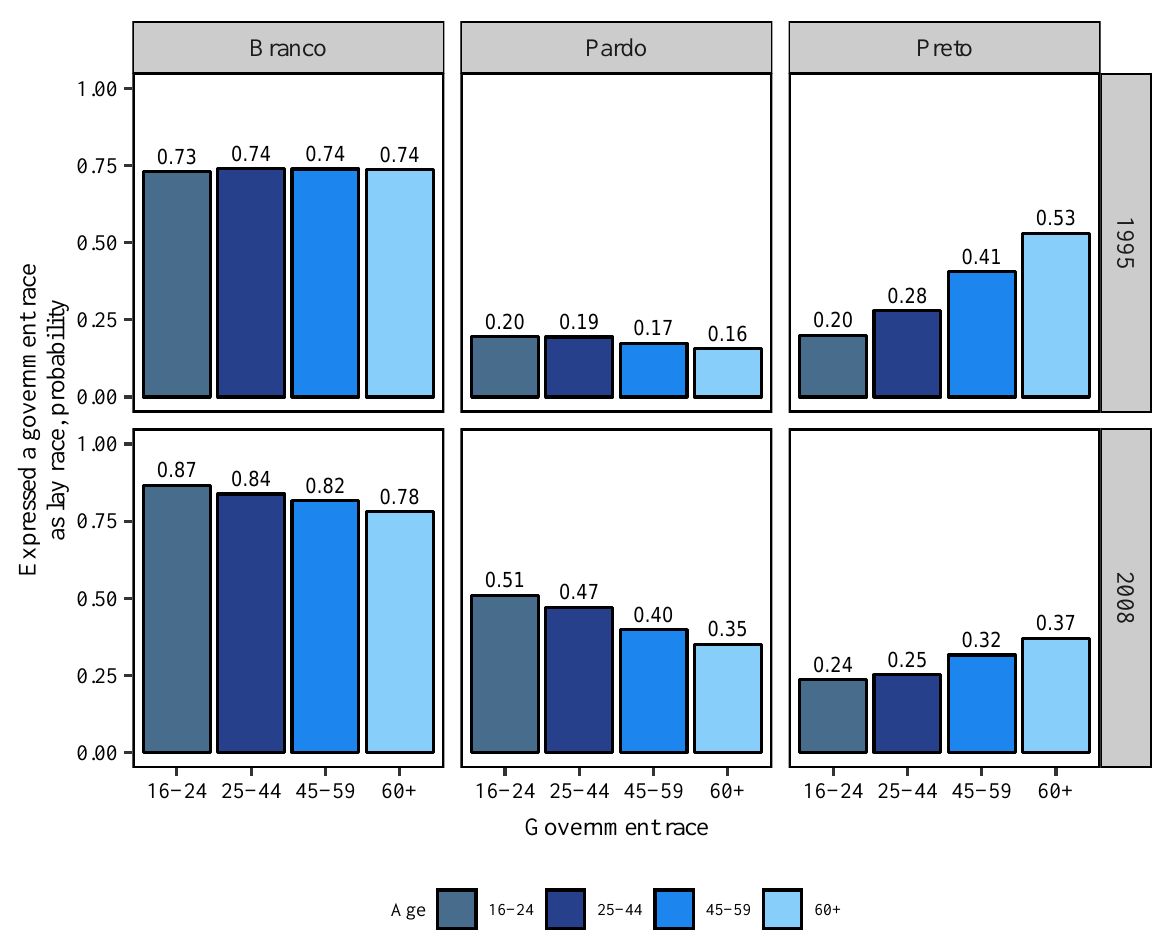
Figure 7: Average predicted probability for dimension alignment by age, 1995 and 2008. and lay classification choices. Specifically, the coefficient for year (denoted by the square symbol in Figure 4) is positive and significant, indicating that pardos (the reference group) are overall more likely to use government classification categories as their lay identification in 2008 compared to 1995, holding all other variables constant. A similar trend of increase in the use of government classification is also found among brancos, though the increase from 1995 to 2008 has been less dramatic for this group than the former. This finding is squarely in line with our descriptive analysis and with the comparison of separate regression models for 1995 and 2008 discussed above. For pretos, however, as shown in Figure 5, when other covariates are held constant, the period effect is nil. Such a result is consistent with the results in Figure 3, which indicate that the propensity for government classification pretos to also express preto as a lay identification remains relatively stable across